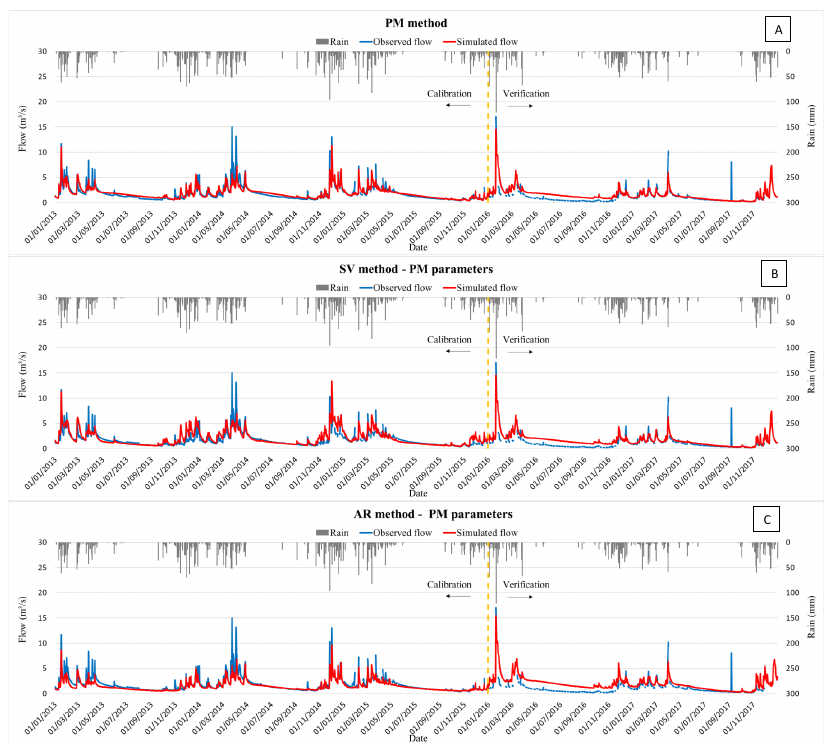
Figure 3. Observed and simulated hydrographs in the calibration period (2013 to 2015) and the verification period (2016 to 2017): ( A ) PM method; ( B ) SV method with application of PM parameters; ( C ) AR method with application of PM parameters.